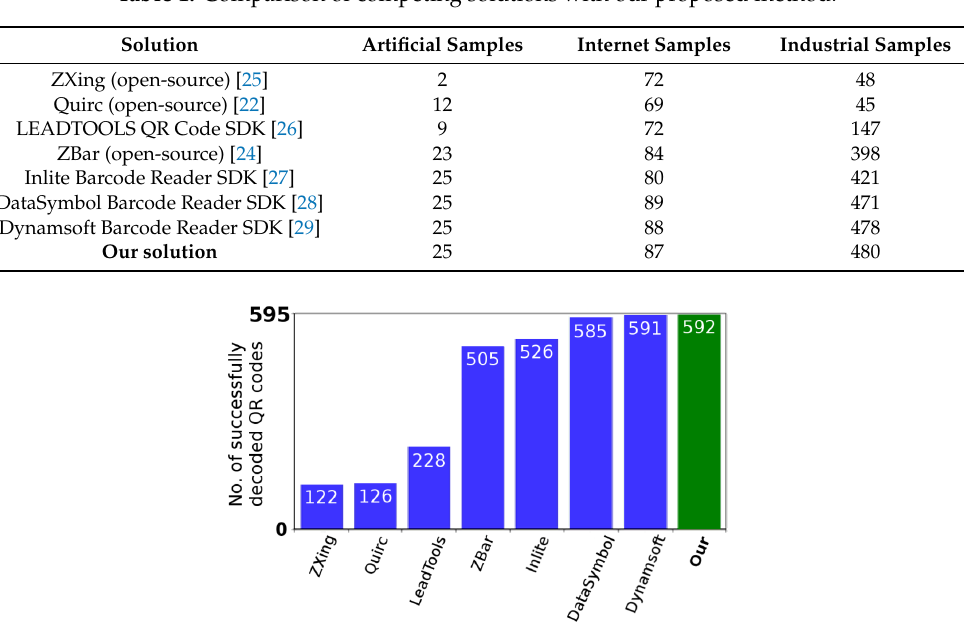
Figure 17. Comparison of the recognition rate of our method against competing solutions.